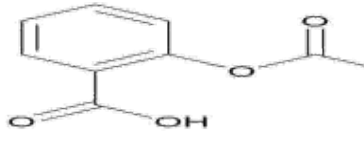
Figure1. Structure of Aspirin